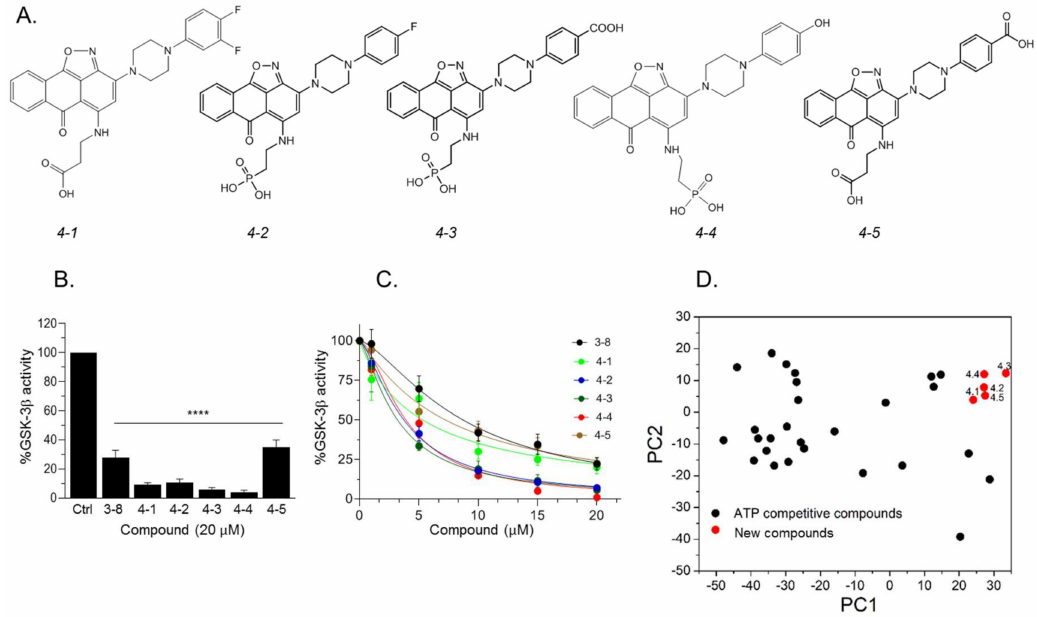
Figure 4. Newly designed GSK-3 SCI molecules. ( A ) Structures of new molecules 4-1 to 4-5 . ( B ) In vitro GSK-3 β kinase assays were conducted with new compounds and 3-8 (20 µ M each). Results show the percentage of GSK-3 β activity without inhibitor (100%) and represent the mean of three independent experiments ± SEM analyzed by one way ANOVA with Dunnett’s multiple comparisons. **** p < 0.0001. ( C ) Dose–response curves of GSK-3 β inhibition of new compounds and as compared to 3-8 . Results are mean of three independent experiments ± SEM. For 4-3 and 4-4 * p < 0.05 for all concentrations, for the rest of the molecules, * p < 0.05 at concentrations ≥ 5 µ M as determined by one way ANOVA with Dunnett’s multiple comparisons, new compounds vs. 3-8 . ( D ) PCA analysis of new compounds 4-1 to 4-5 together with GSK-3-ATP competitive inhibitors (listed in Table S4). The first and second PCs accounted for 81.8% and 7.7% of the original variance and are shown at the X - and Y -axis respectively. Black circles represent the ATP competitive inhibitors, red circles represent new